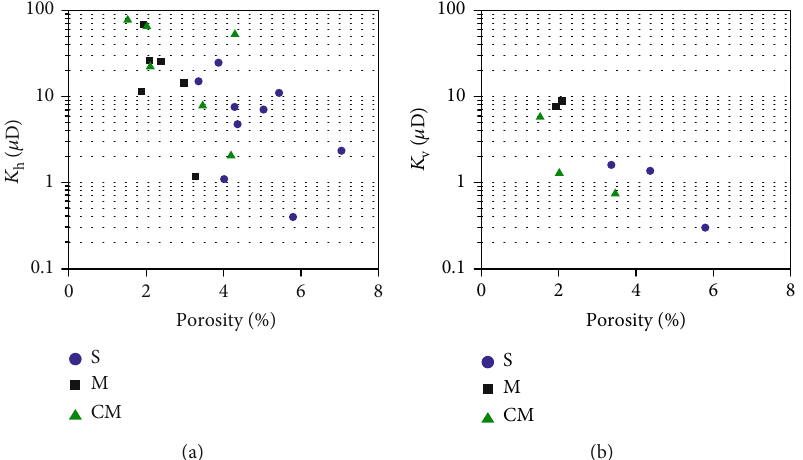
Figure 14: E ff ect of lithology on the relationship between permeability and porosity. (a) The permeability ( K bedding. (b) The permeability ( K v ) was measured perpendicular to